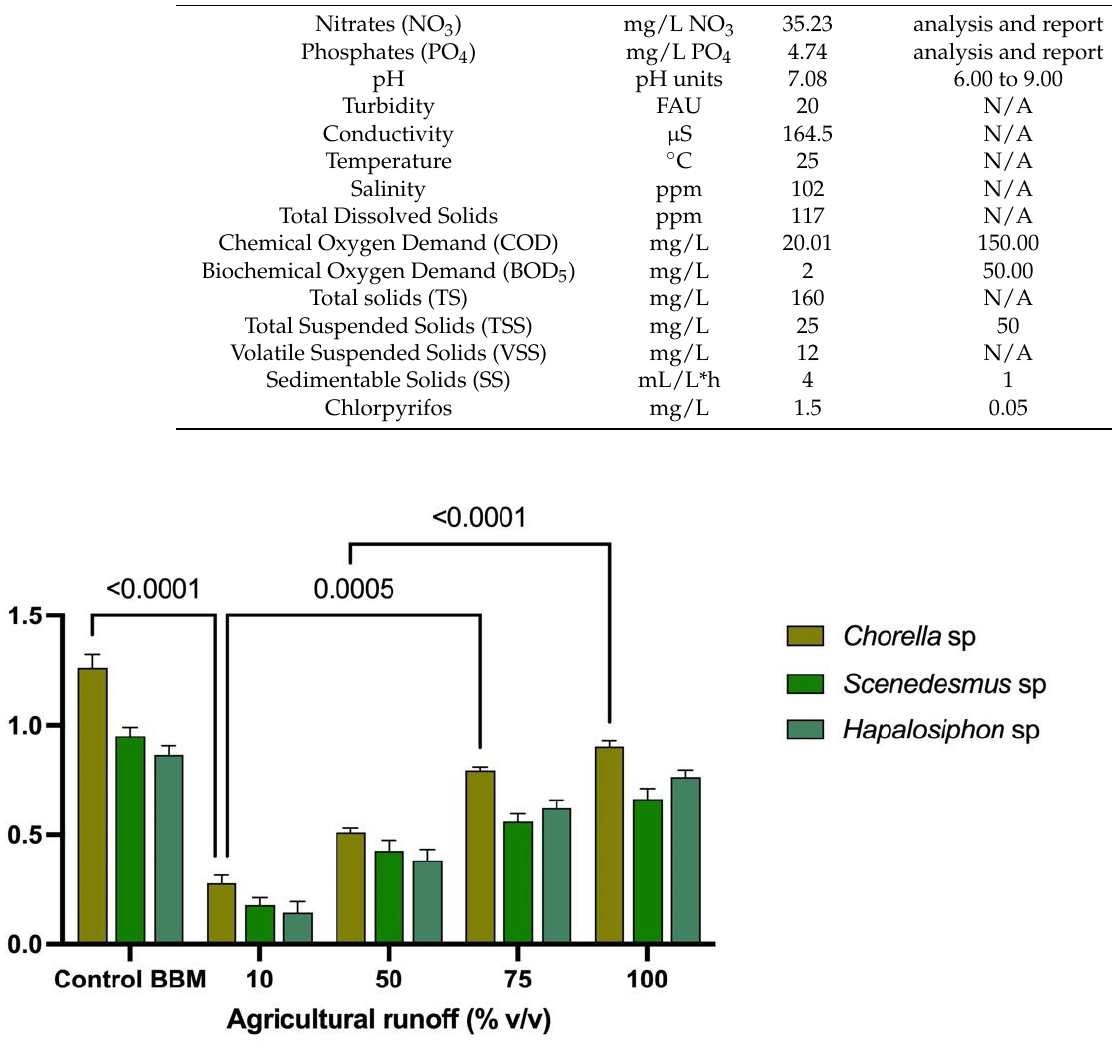
Figure 1. Strains grow in different concentrations of agricultural runoff.